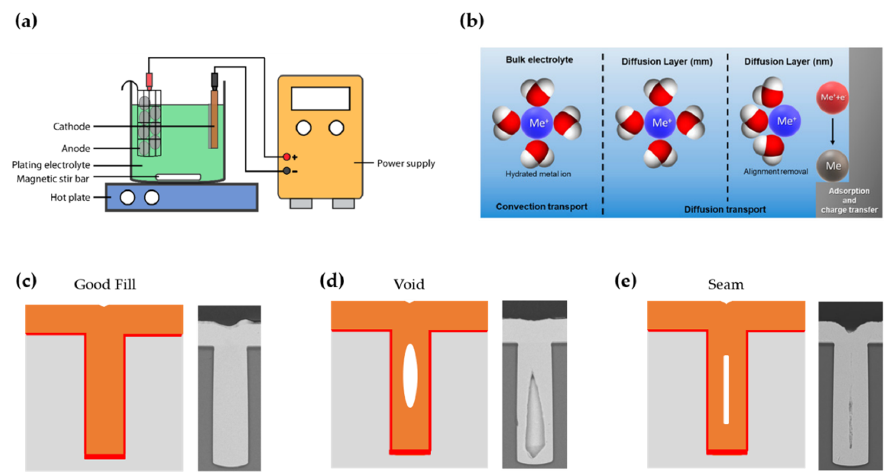
Figure 2. ( a ) Schematic illustration of an electroplating apparatus (reprinted with permission from [78].